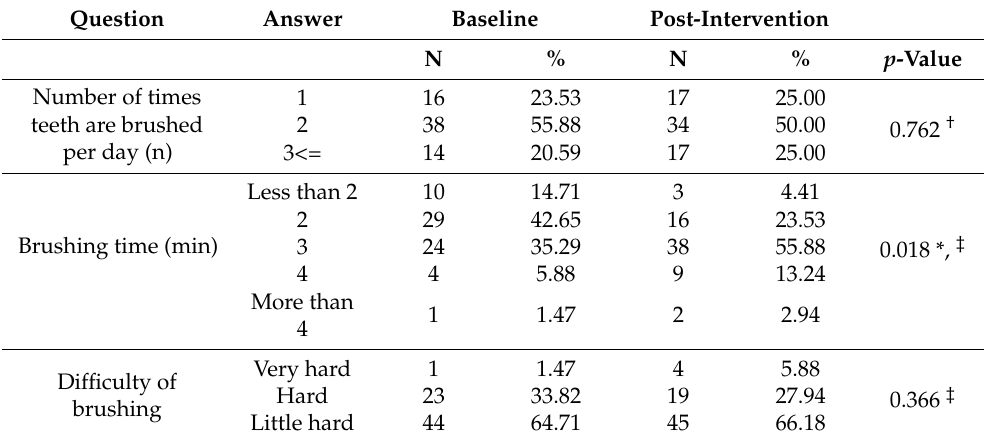
Table 4. Answers on questionnaire survey at baseline and post-intervention for